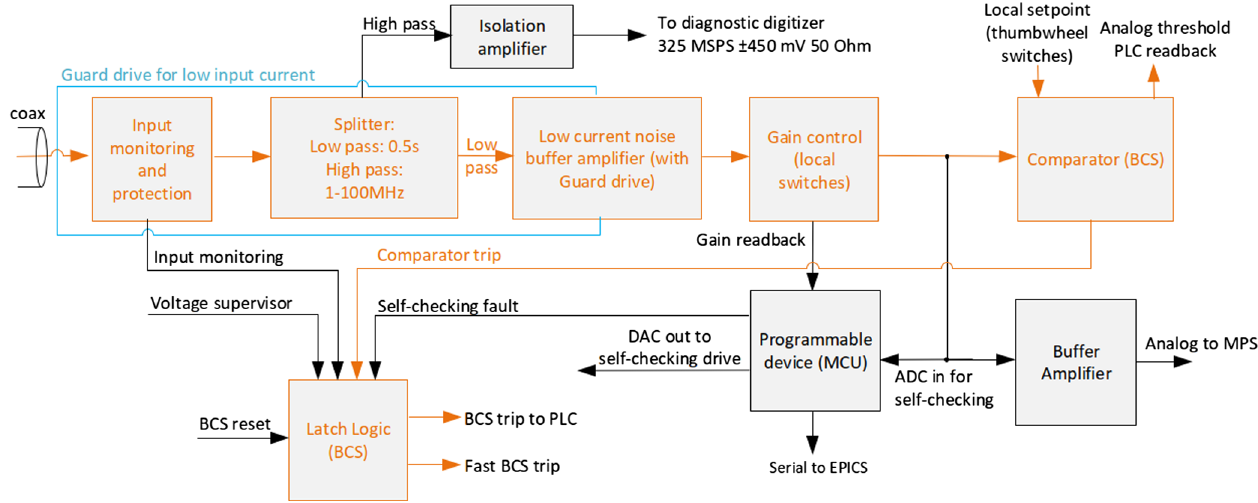
FIG. 11. A functional block diagram of the BLM electronics. Highlighted boxes show the direct path for beam